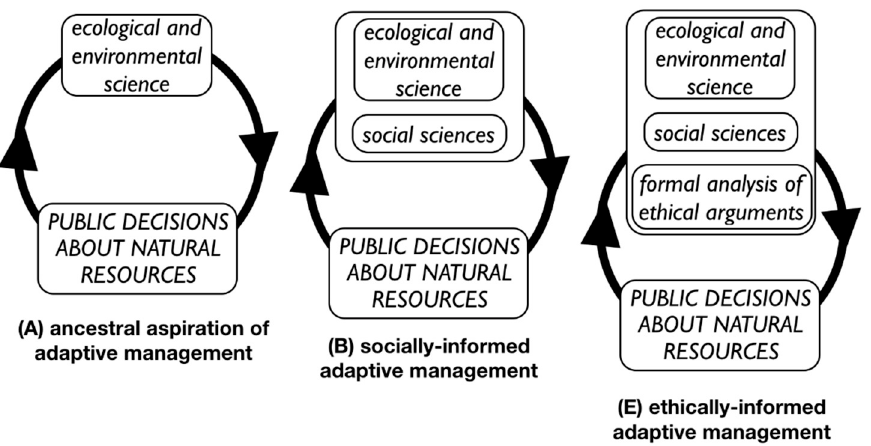
Figure 1. Evolution of public decision-making for natural resources. The upward-pointing arrowhead refers to evaluation of the consequences of a policy; the downward-pointing arrowhead refers to revision of policy based on the evaluation. Adapted from Reference [16].